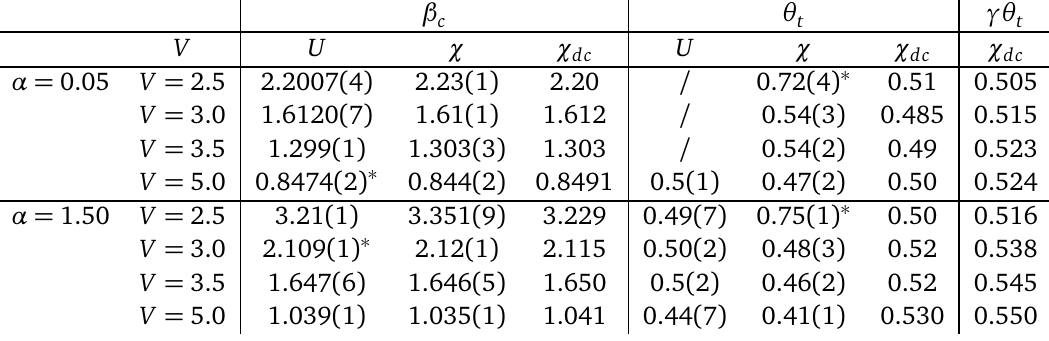
, θ , and γθ (see text) for the c t t ). Estimates marked with an asterisk dc